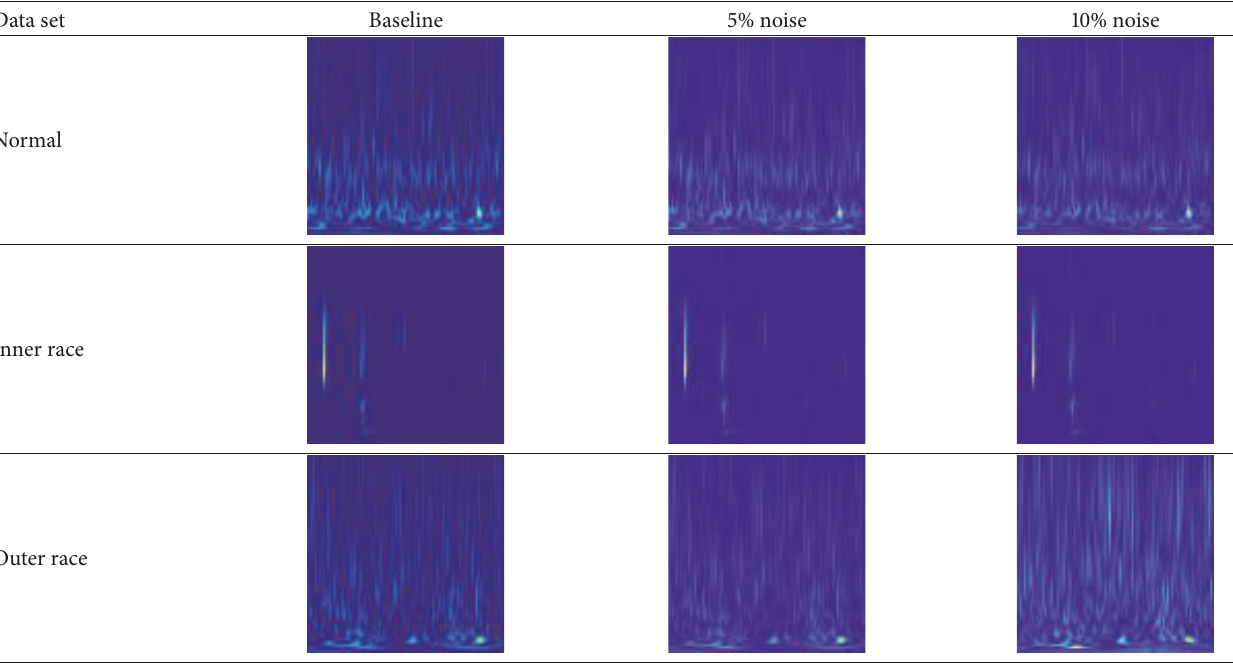
Table 26: MFPT 96 × 96 scalogram images with noise injected.